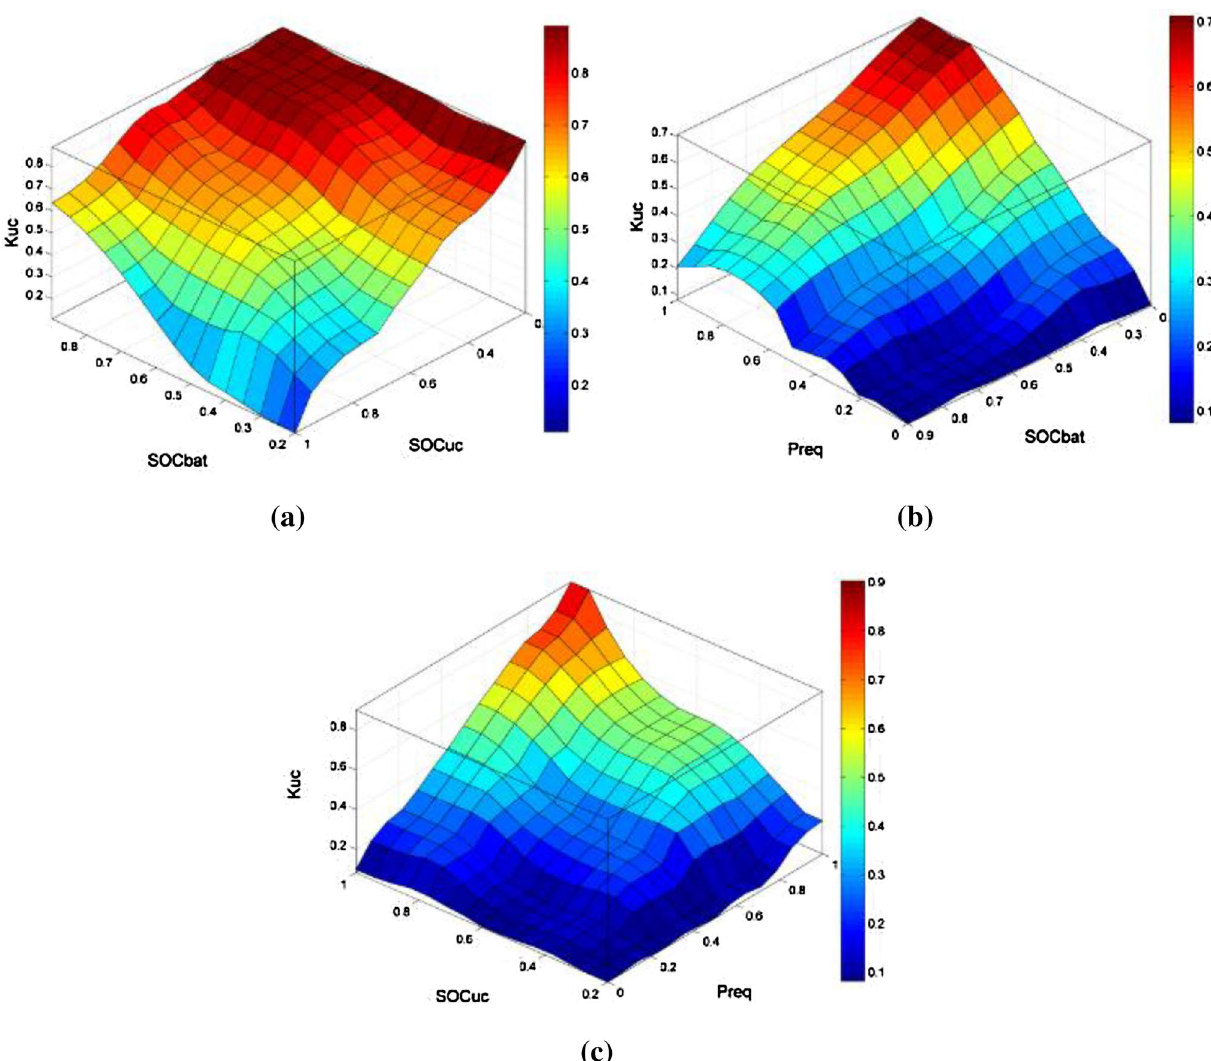
Fig. 8 Regular surface graph of fuzzy controller: (a)Input and output mapping surfaces in charging mode; (b)Input ( P put mapping surfaces in discharging mode;(c)Input ( P